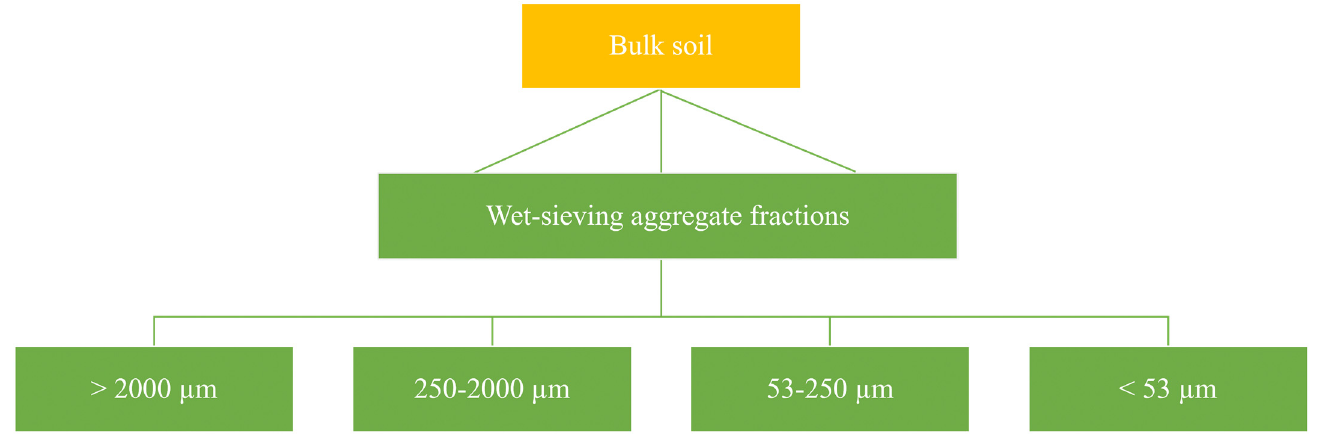
Figure 4. Soil aggregation fractionation schemes used to obtain aggregates and subfractions within microaggregate and microaggregates.